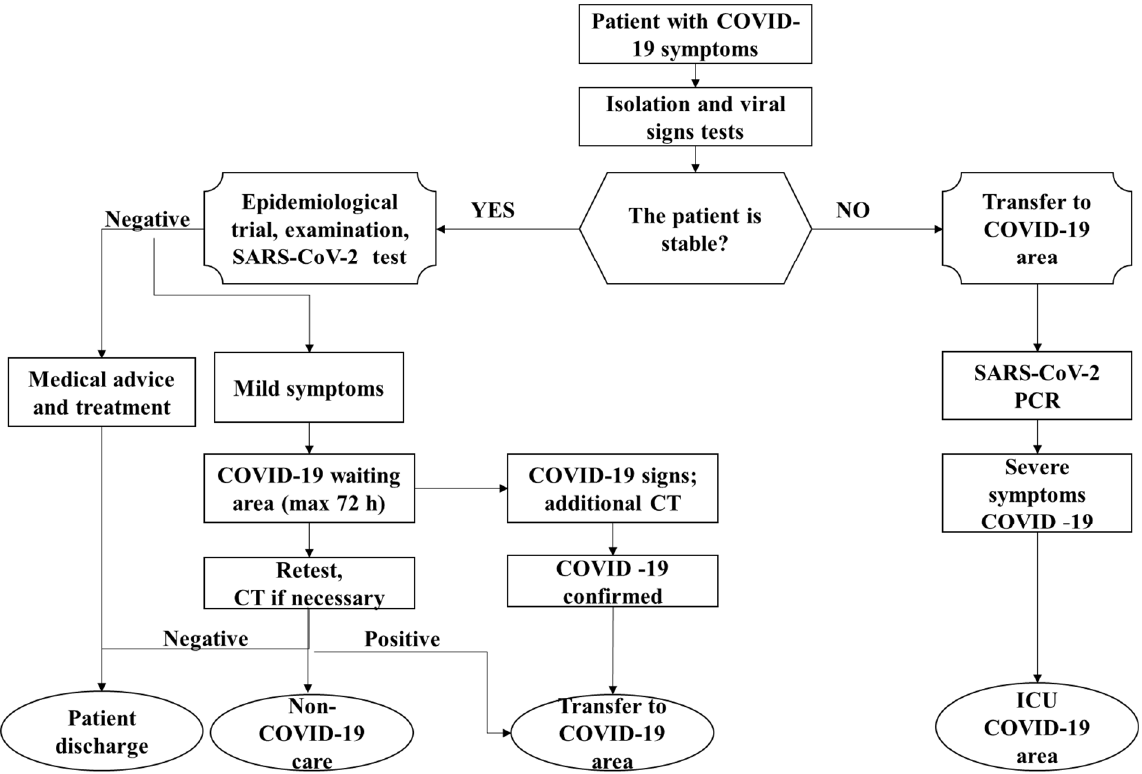
Figure 2. Pandemic workflow for hospital intake procedures.